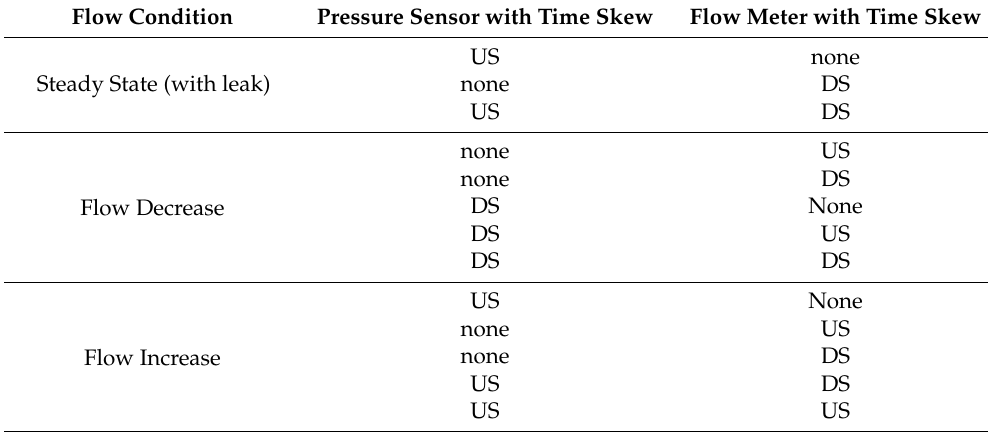
Table 2. Tested scenarios of time skew.